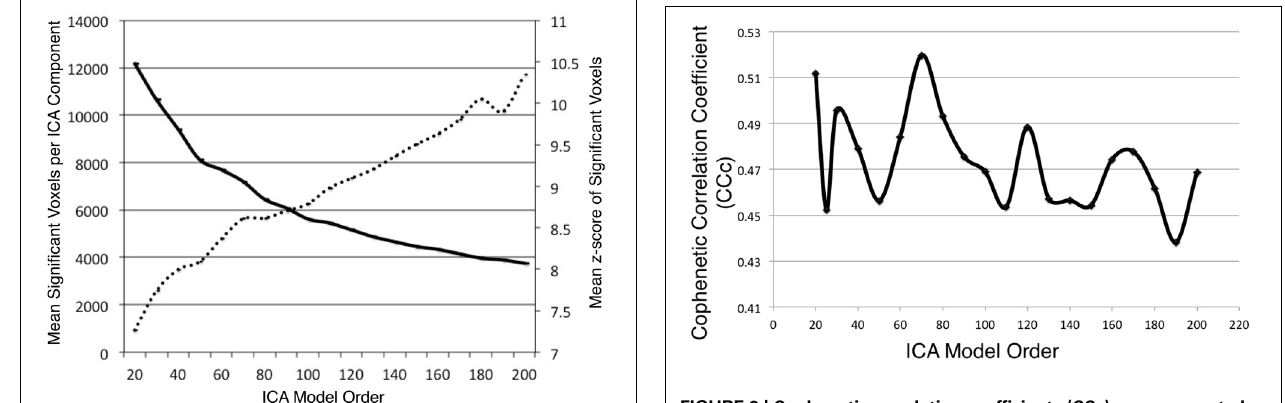
FIGURE 3 | Cophenetic correlation coefficients (CC c ) were computed for the BrainMap metadata matrices across ICA model orders. CC c values indicate how well the HCA results fit the corresponding BrainMap metadata. The ICA model orders yielding the two highest CC c values were generated with metadata from the d = 20 (CC c = 0 . 5119) and d = 70 ( CC c = 0 . 5198)